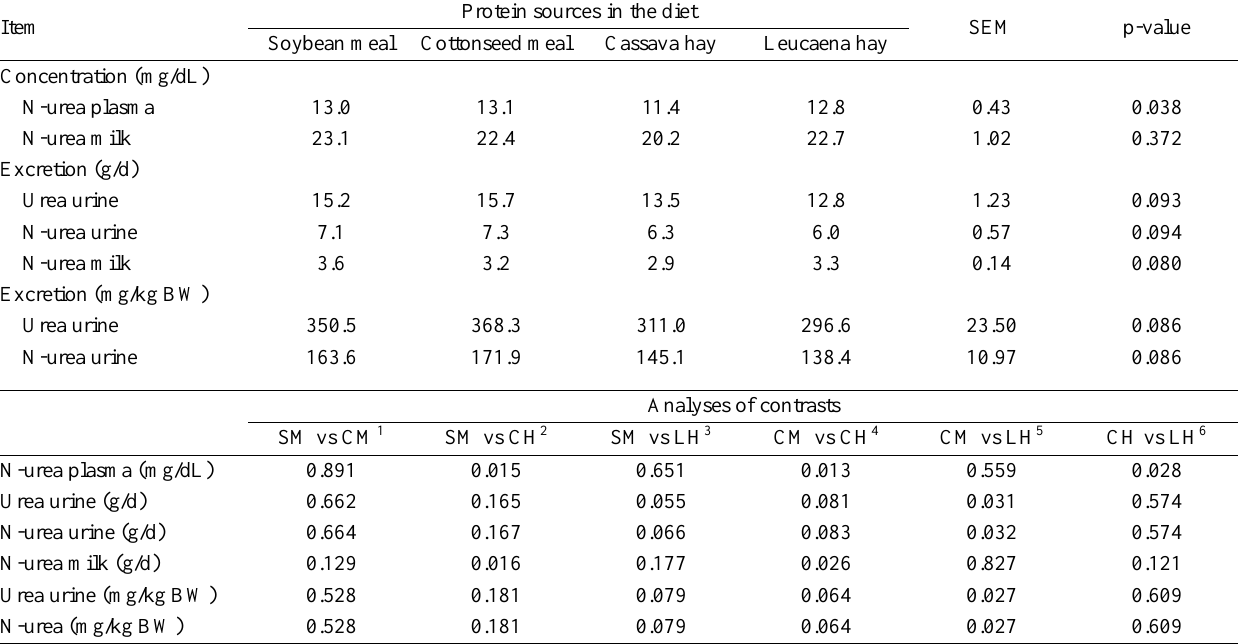
Table 2. Excretion and concentration of urea and urea nitrogen in urine, milk and plasma in lactating goats fed with diets containing different protein sources in the concentrate Protein sources in the diet Item